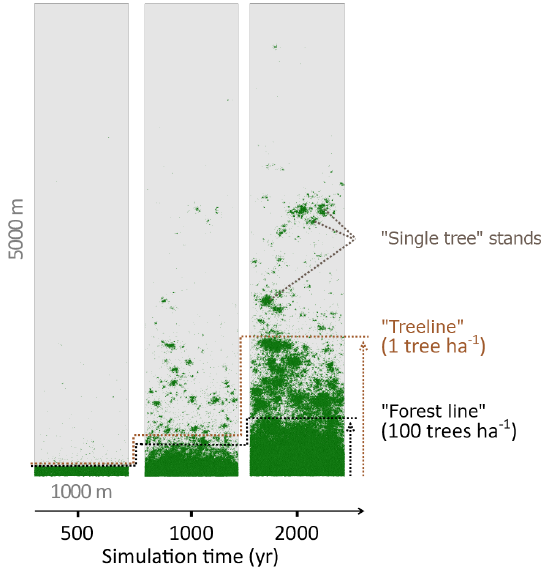
Figure 2. Simulated treeline advances along a hypothetical south– north transect across the modern forest line. Simulations were ini- tialised with seeds in the southernmost 100m area and run for 2000 years. In the beginning, trees established beyond the treeline (mean density falling below 1treeha − 1 ) and formed “single tree” stands in the tundra, which then acted as nuclei for further range expansion, so that in following years the treeline and the forest line (mean density falling below 100treesha − 1 ) could advance north- wards, forming open forest.